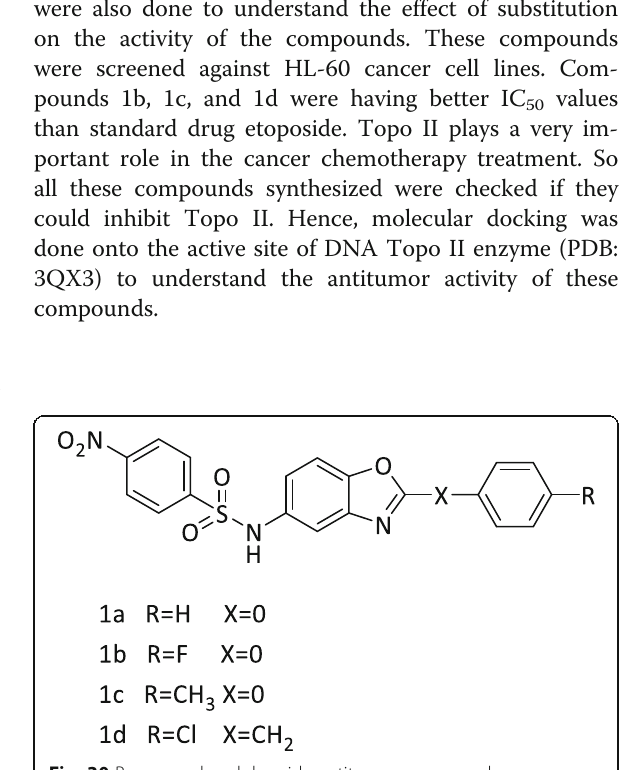
Fig. 28 Benzoxazole/benzimidazole VEGFR-2 inhibition compounds